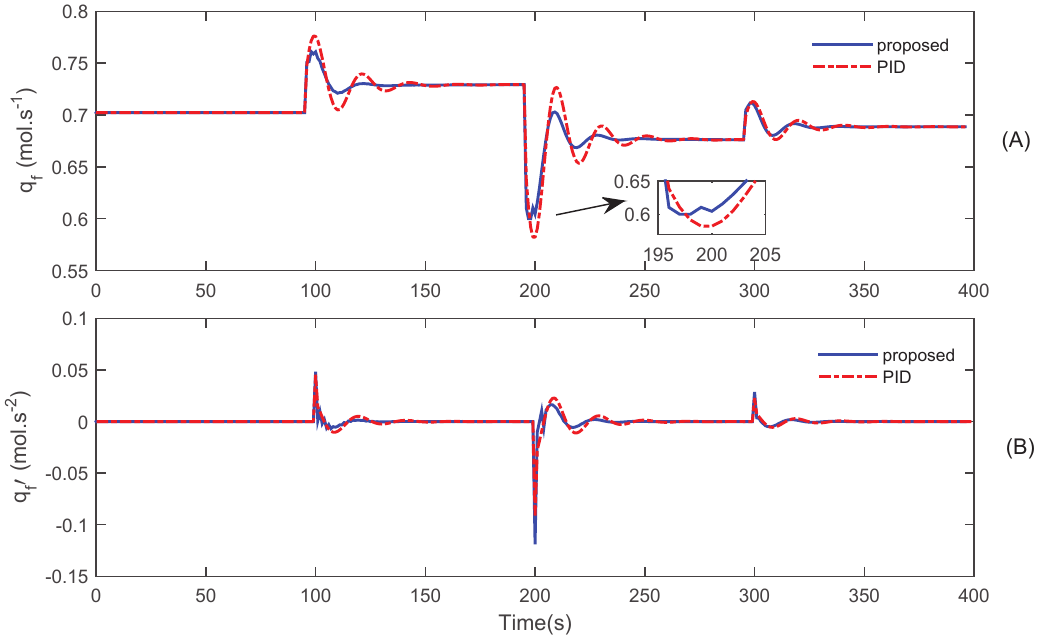
Figure 7. The curves of the natural gas flow rate ( A ) and the natural gas flow acceleration ( B ).